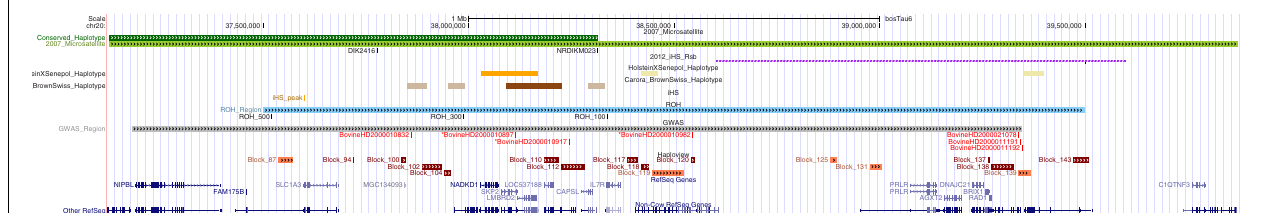
FIGURE 7 | Comparison of BTA20 regions associated with the SLICK hair phenotype derived from different genetic analyses. Regions of association are highlighted from prior research of the SLICK hair phenotype and compared to the results for this study within an annotated UCSC Genome Browser window. The browser window encompasses genome coordinates from UMD 3.1 on BTA20:37–40Mb. The top two green lines depict the associated region (light green) and conserved haplotype (dark green) from 2007 (Mariasegaram et al., 2007). The microsatellites, DIK2416 and NRDIKM023 are identified just below as black lines and labeled. The signature of selection identified by (Flori et al., 2012) is shown in purple. The conserved haplotype regions within the SLICK Holsteins with Senepol admixture and Carora (Brown